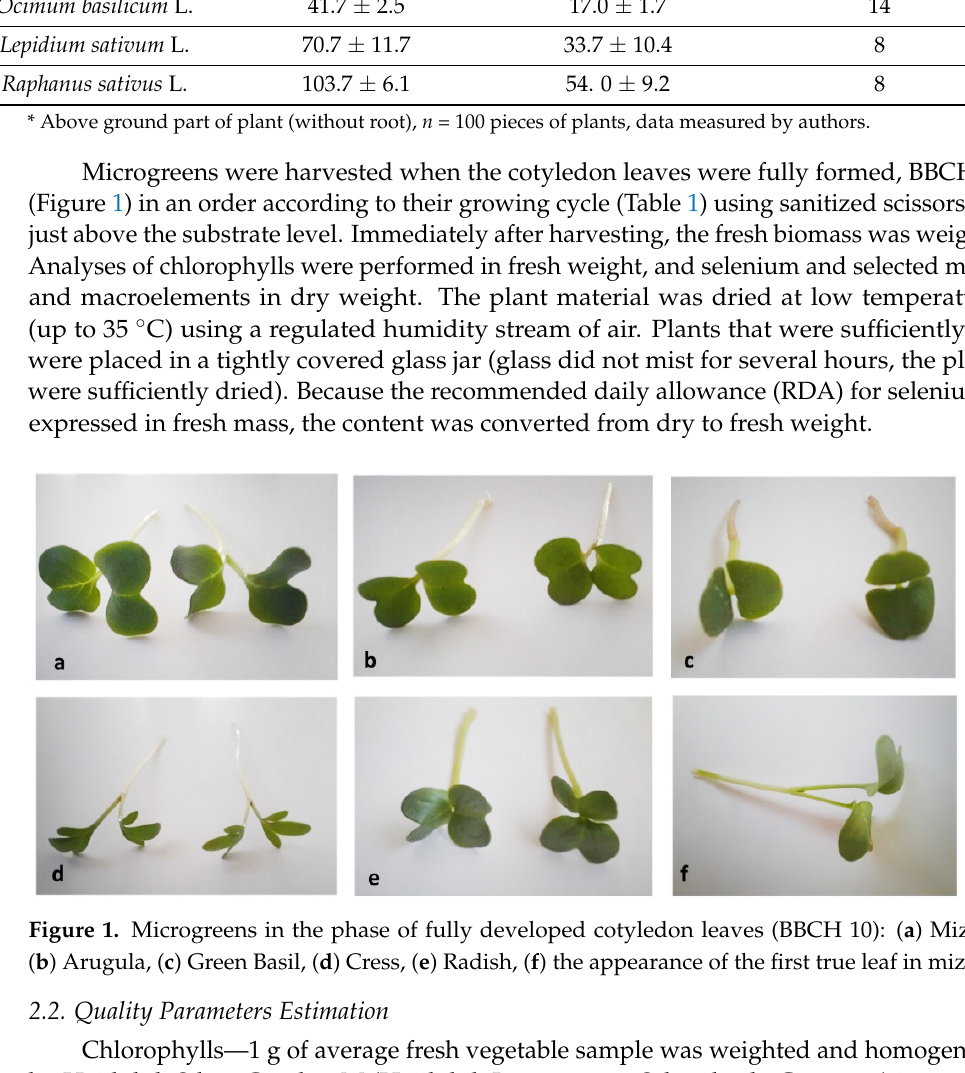
Table 1. Quantitative parameters and growing cycle of microgreen species.